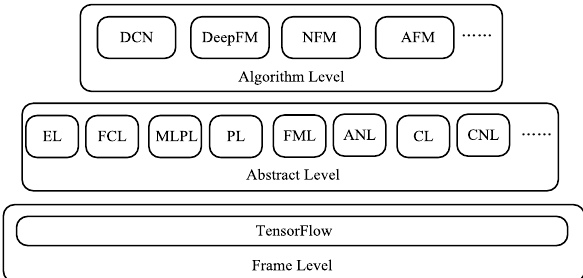
Fig. 1 Architecture diagram of